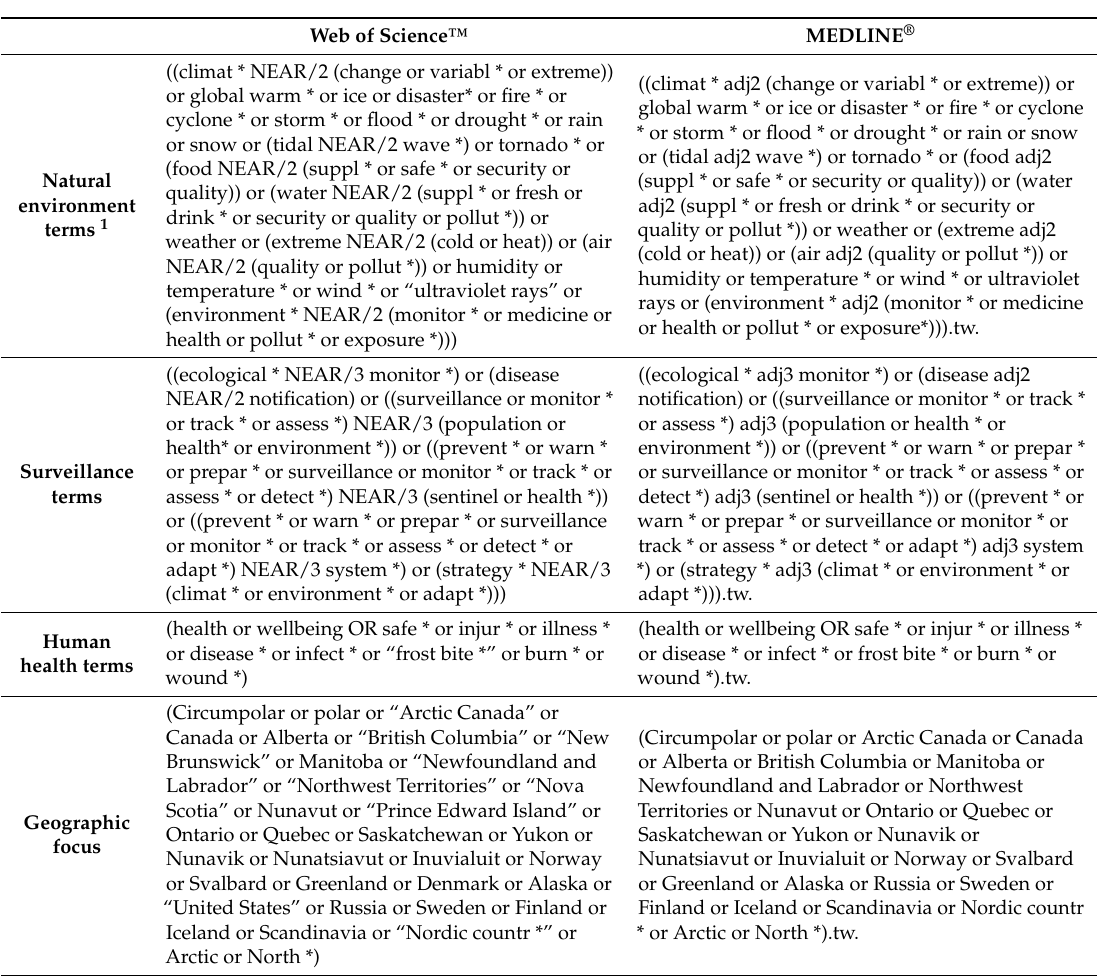
Table 1. Finalized search strings for Web of Science™ and MEDLINE ® aggregator databases to identify articles related to integrated surveillance strategies in Arctic and Subarctic regions of the Circumpolar North that involved considerations for the natural environment, human health, and surveillance (2005–2016).